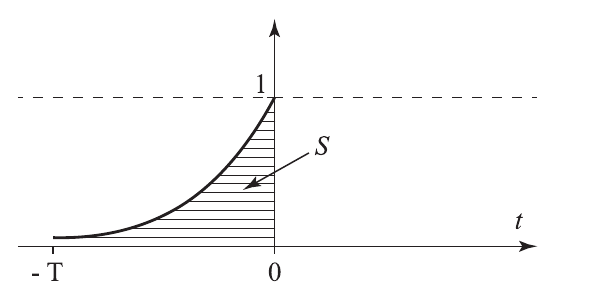
Figure 1. The set S